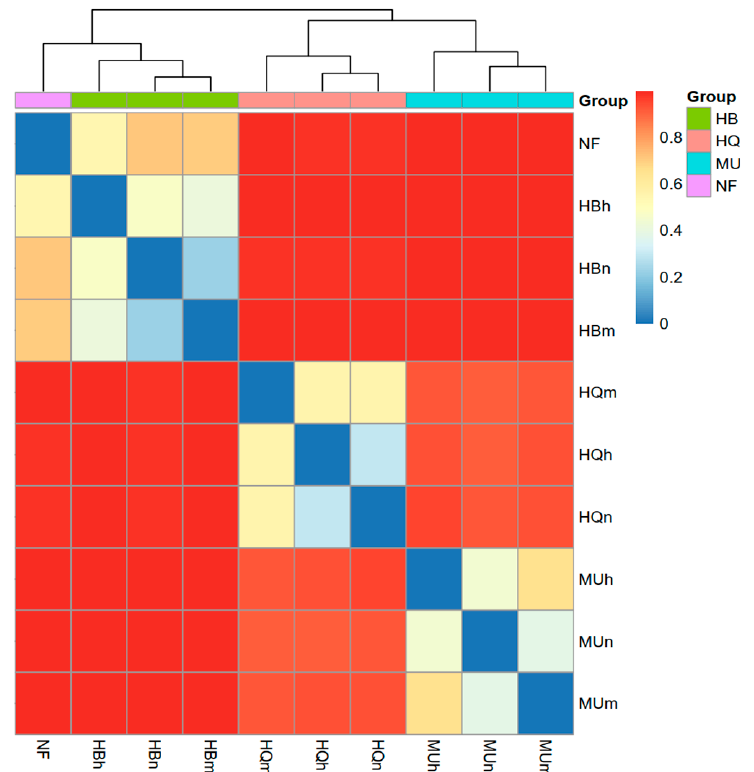
Figure 6. Bray–Curtis distance heatmap of each P. sylvestris stand across three sandy lands. Color varies from blue to red, representing dissimilarities in EM fungal community composition from low (blue) to high (red).